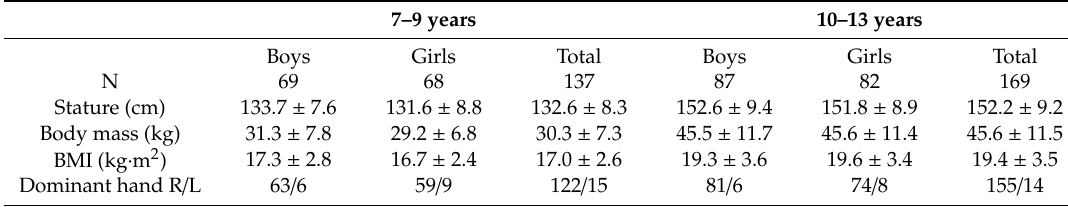
Table 1. Participant characteristics. Values are presented as mean ± SD.